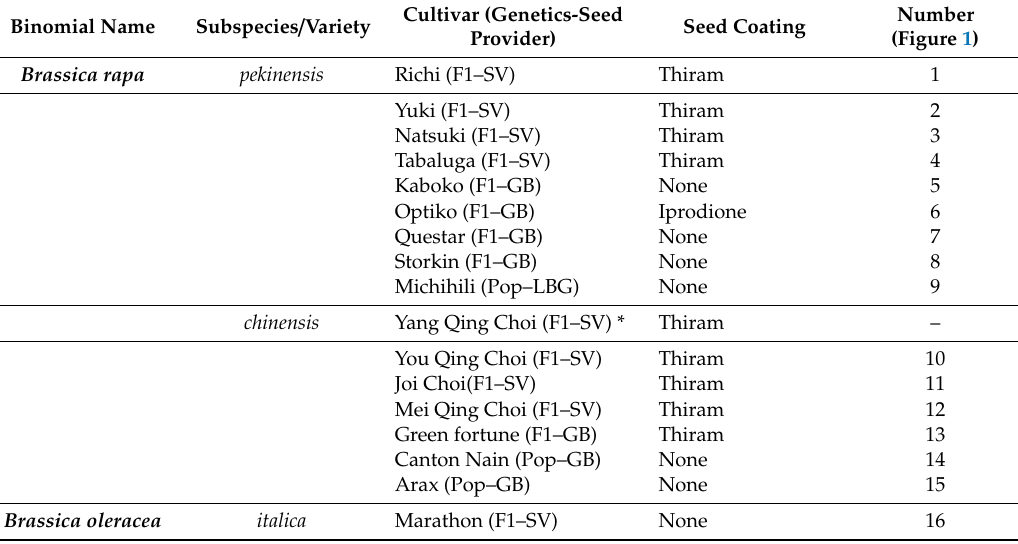
Table 1. Varietal diversity of Chinese cabbages selected for plant laboratory and field choice experiments and broccoli used as infestation reference (F1 = F1 hybrid; Pop = population—i.e., mixture of genotypes); SV = Sakata Vegetable; GB = Graines Baumaux; LBG = La Bonne Graine. The asterisk indicates the variety excluded from the field